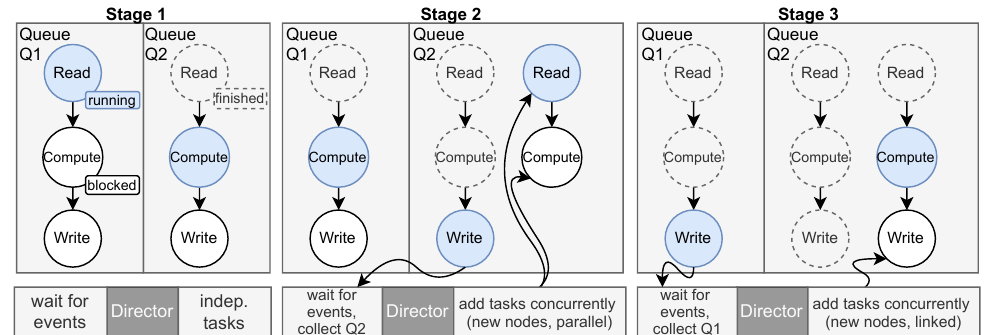
Figure 3. Example of interaction with the DAG from oneAPI’s perspective while running a dynamic approach with two